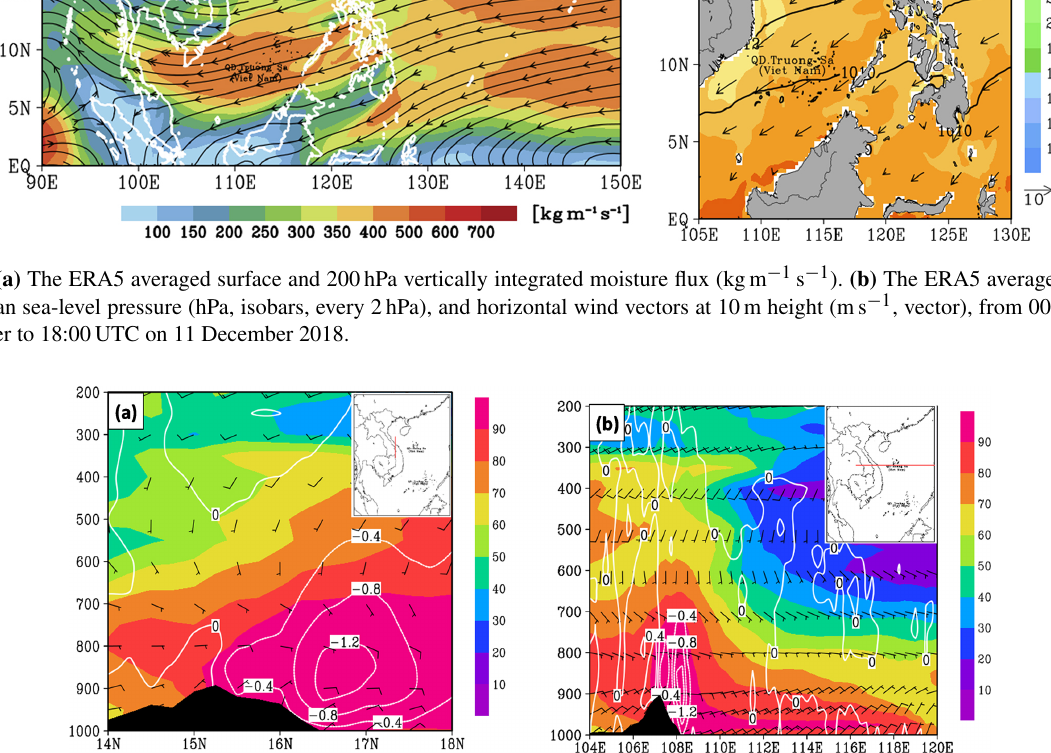
Figure 6. (a) The ERA5 the south–north vertical cross-section along 107.5 ◦ E (see insert) of averaged horizontal wind (ms − 1 , vectors) and vertical motions (Pas − 1 ; white contours, negative for upward motion), and relative humidity (%, shaded), from 00:00UTC on 8 December to 18:00UTC on 11 December 2018. The topography is dark shaded. (b) As in panel (a) , but for the vertical cross-section along 16 ◦